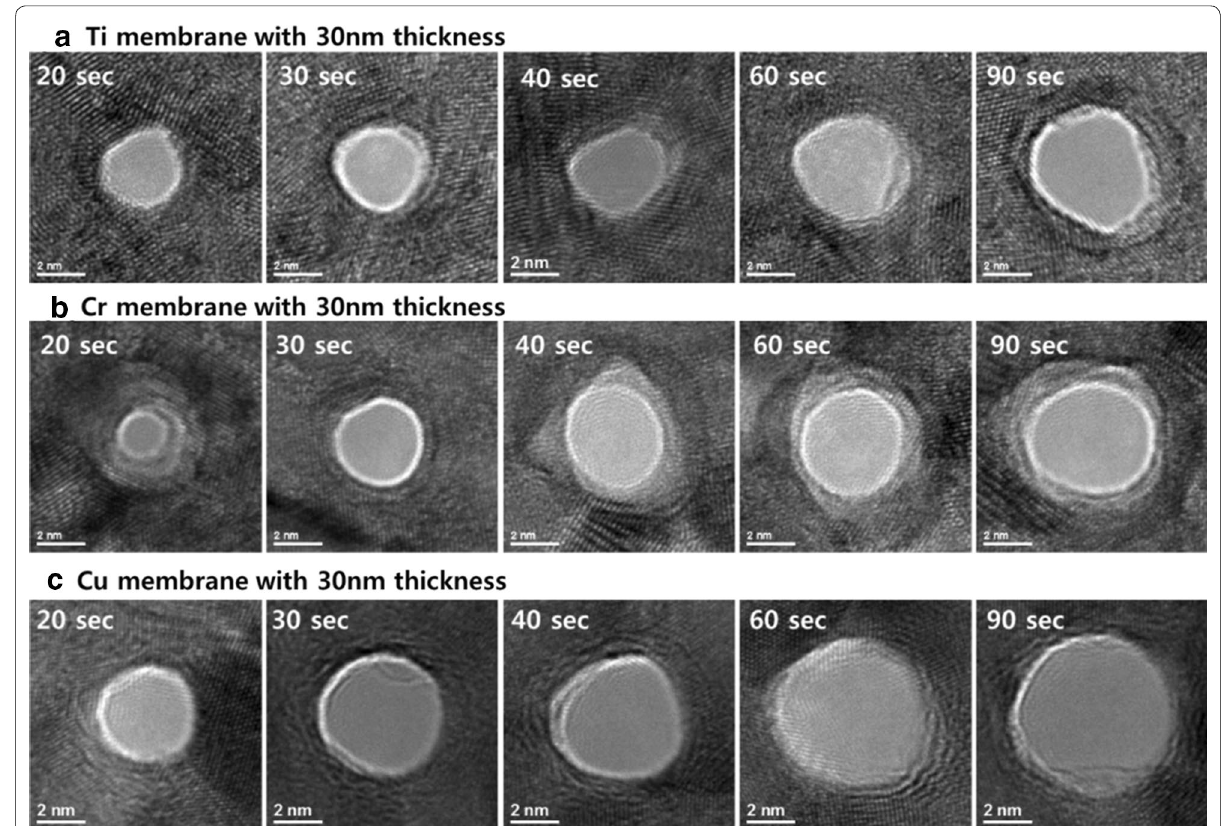
Fig. 2 Nanopore evolution for 30 nm thick a Ti, b Cr, and c Cu membranes with e‑beam exposure time, at 200 kV and 7